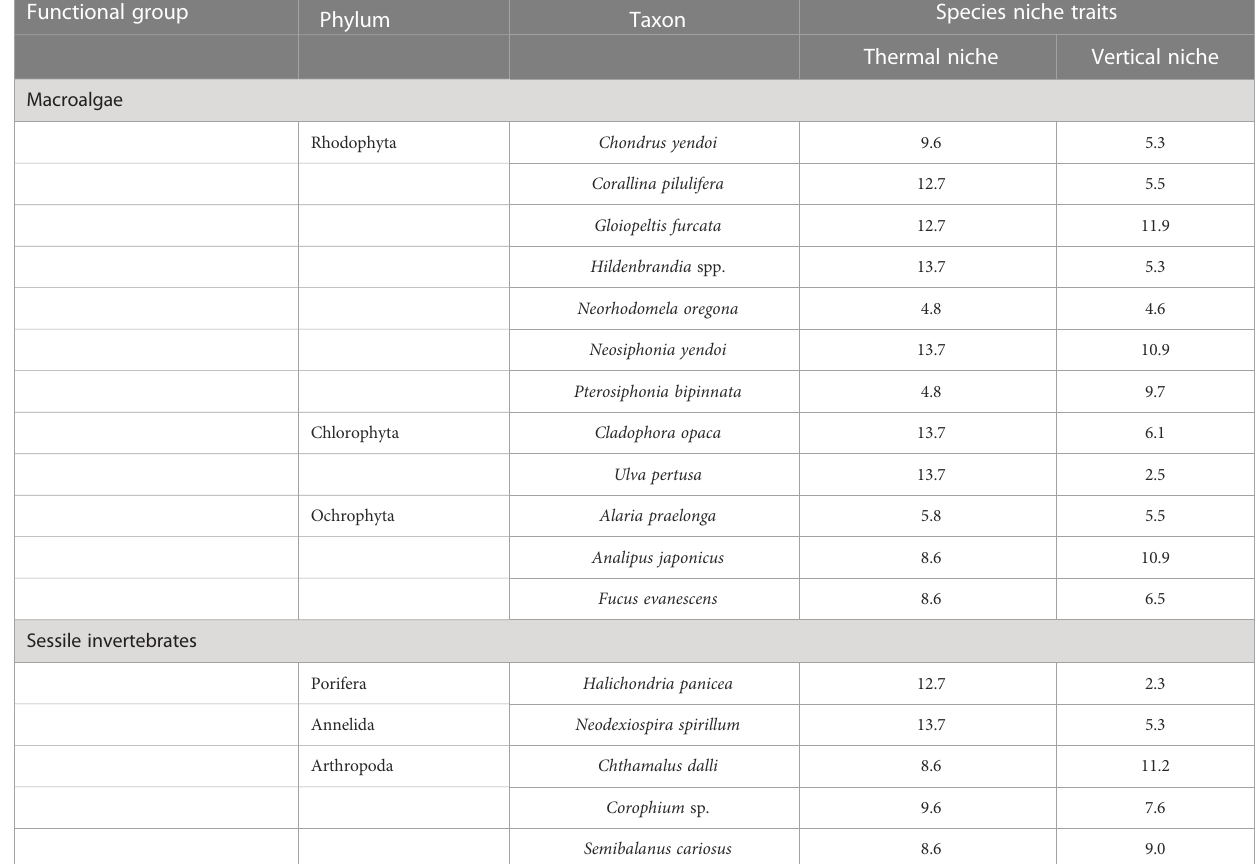
TABLE 8 Species niche traits of 17 sessile species.